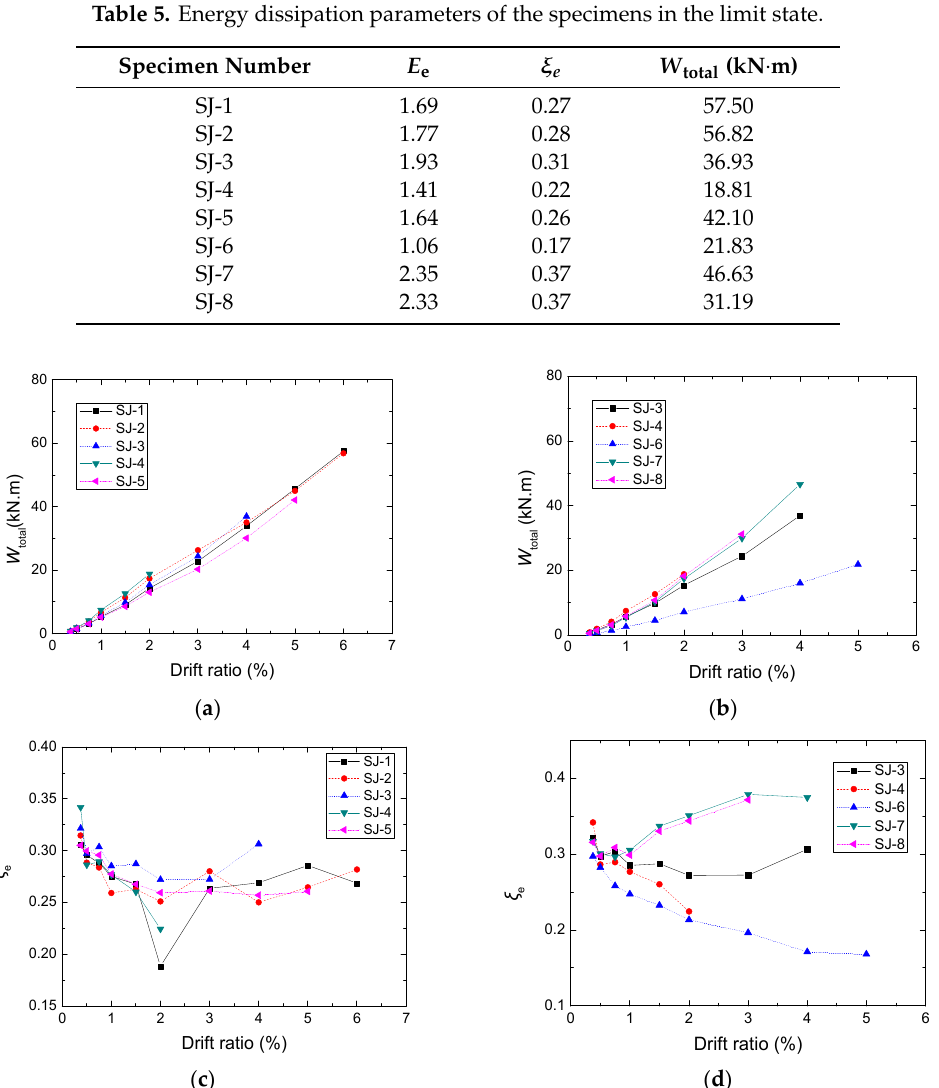
Figure 22. W total and ξ e versus the drift ratio. ( a , c ) Specimens SJ-1 through SJ-5; ( b , d ) Specimens SJ-3, SJ-4, SJ-6 through SJ-8.